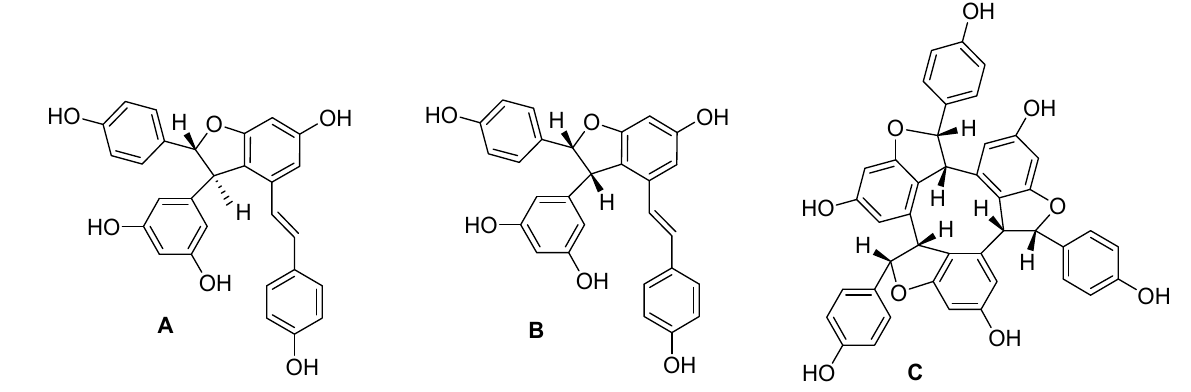
Figure 2. Chemical structures of ε -viniferin ( A ), δ -viniferin ( B ), and α -viniferin ( C ). Determining the absolute configuration to differentiate between (+) and ( − )- ε -viniferin, however, is more challenging. For known compounds, their [ α ] D values can be compared with those in the literature. Nevertheless, due to the difficulties in assigning absolute configurations to stilbenoid oligomers, many compounds have been reported with only their relative configurations assigned. Since (+)- ε -viniferin is considered a major stilbenoid intermediate for larger oligomers, the structures containing viniferin moieties are normally presented as containing the same configuration when not otherwise determined. In the many reports of complex oligomers, only the relative configuration is assigned [62]. trans conformations for these hydrogens is an area of confusion when dealing with vinif- erins, which also contain a trans (E) or cis (Z) double bond. tral data exhibited characteristic bands at 3393 cm − 1 (OH), 1606, 1513, 1443 cm − 1 (C=C aromatic) and 832 cm − 1 (para-disubstituted benzene). The 1 H-NMR spectra [63,64] were recorded in deuterated acetone with pairs of doublets appearing at δ 7.21 (2H, d, J = 9.0 Hz, H-2A and H-6A) and δ 6.83 (2H, d, J = 8.0 Hz, H-3A and H-5A), integrating two